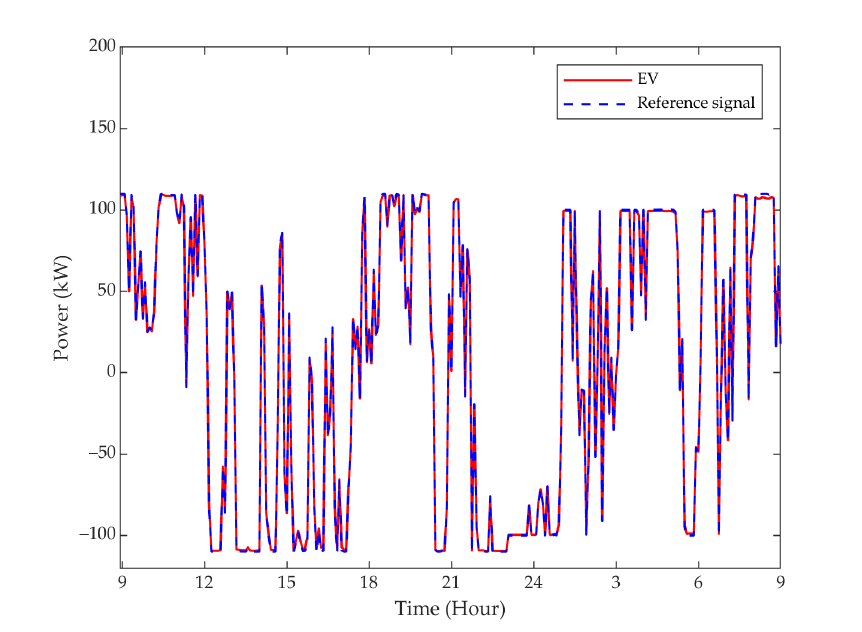
Figure 14. The 40 EV s charging and discharging profile for frequency regulation in Scenario